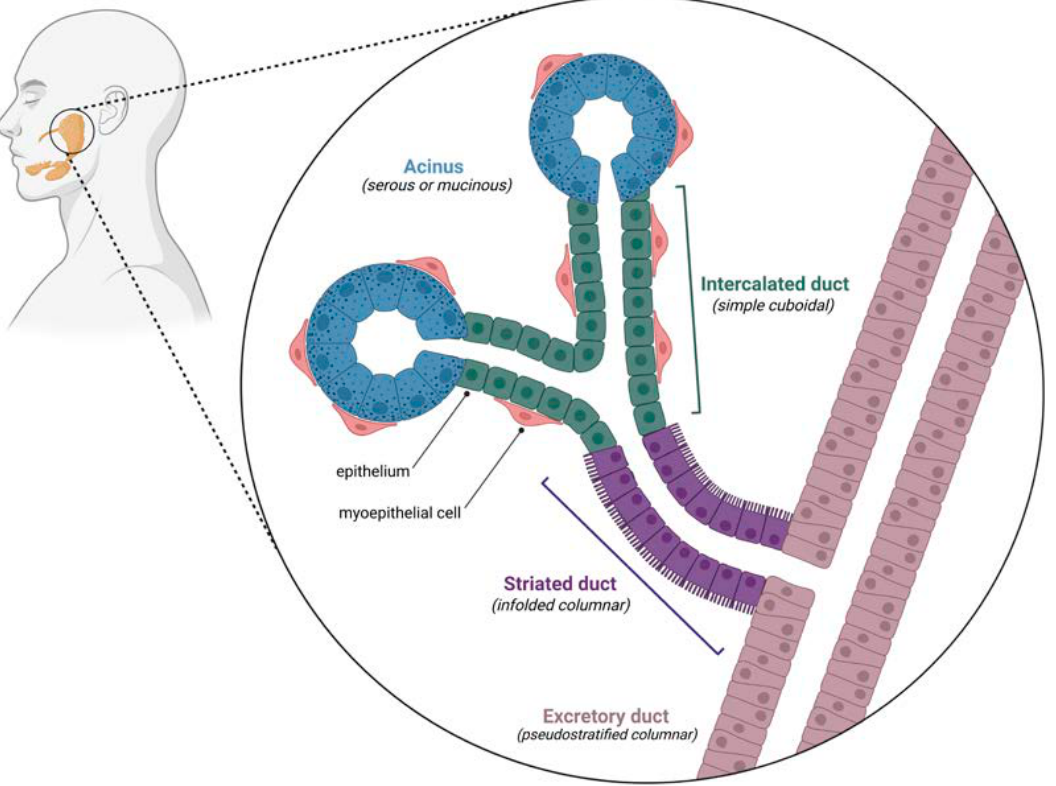
Figure 1. Schematic illustrating the spatial arrangement of the salivary ductal system.